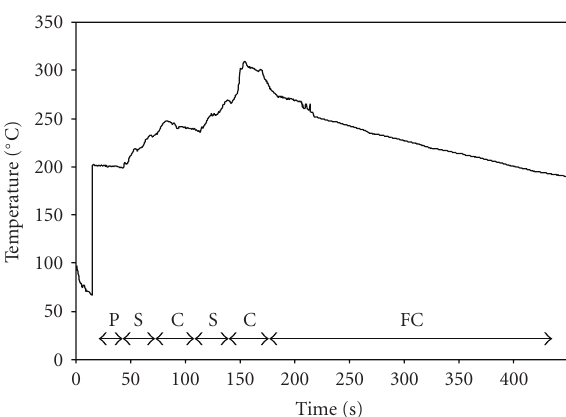
Figure 1: Temperature evolution at spraying of WC-8Co. P: preheating; S: spraying; C: cooling (by compressed Ar); FC: “fine” cooling (by compressed Ar with reduced flow rate). The signal was collected from a thermocouple screwed on the substrate backside.